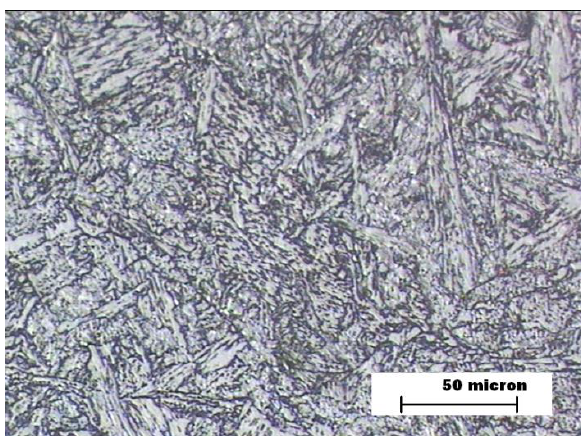
Figure 8. Sample C. HAZ microstructure. Materials 2019 , 12 , x FOR PEER REVIEW